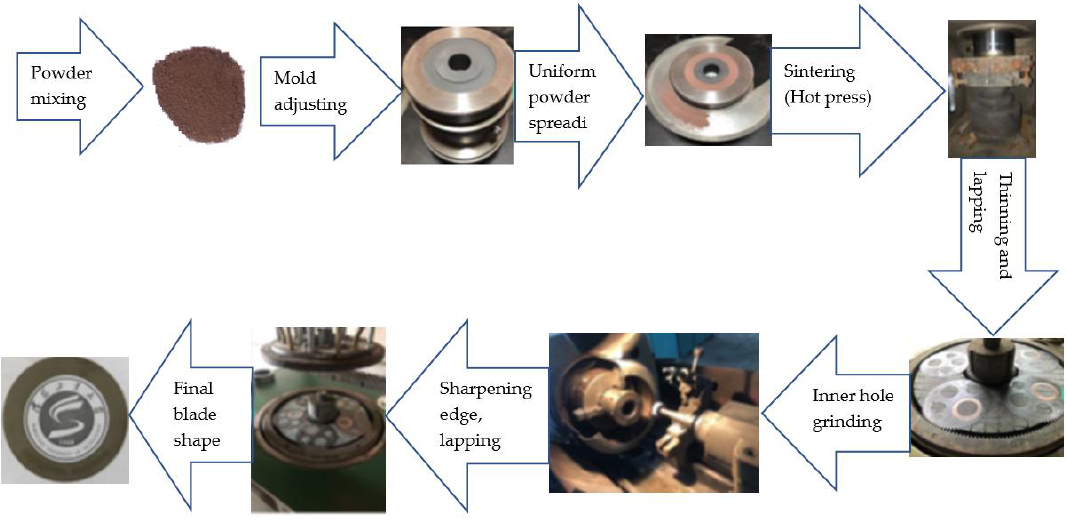
Figure 3. Preparation of dicing blades [15].